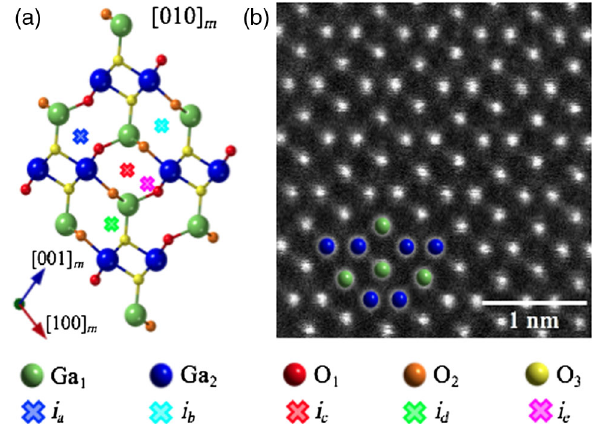
FIG. 1. Crystal structure and experimental image of β -Ga 2 O 3 . (a) Crystal structure of β -Ga 2 O 3 along the ½ 010 (cid:2) m direction with five possible interstitial sites ( i a − e ). (b) Atomic resolution HAADF-STEM image of a ½ 010 (cid:2) m Sn-doped β -Ga 2 O 3 bulk crystal from a defect-free